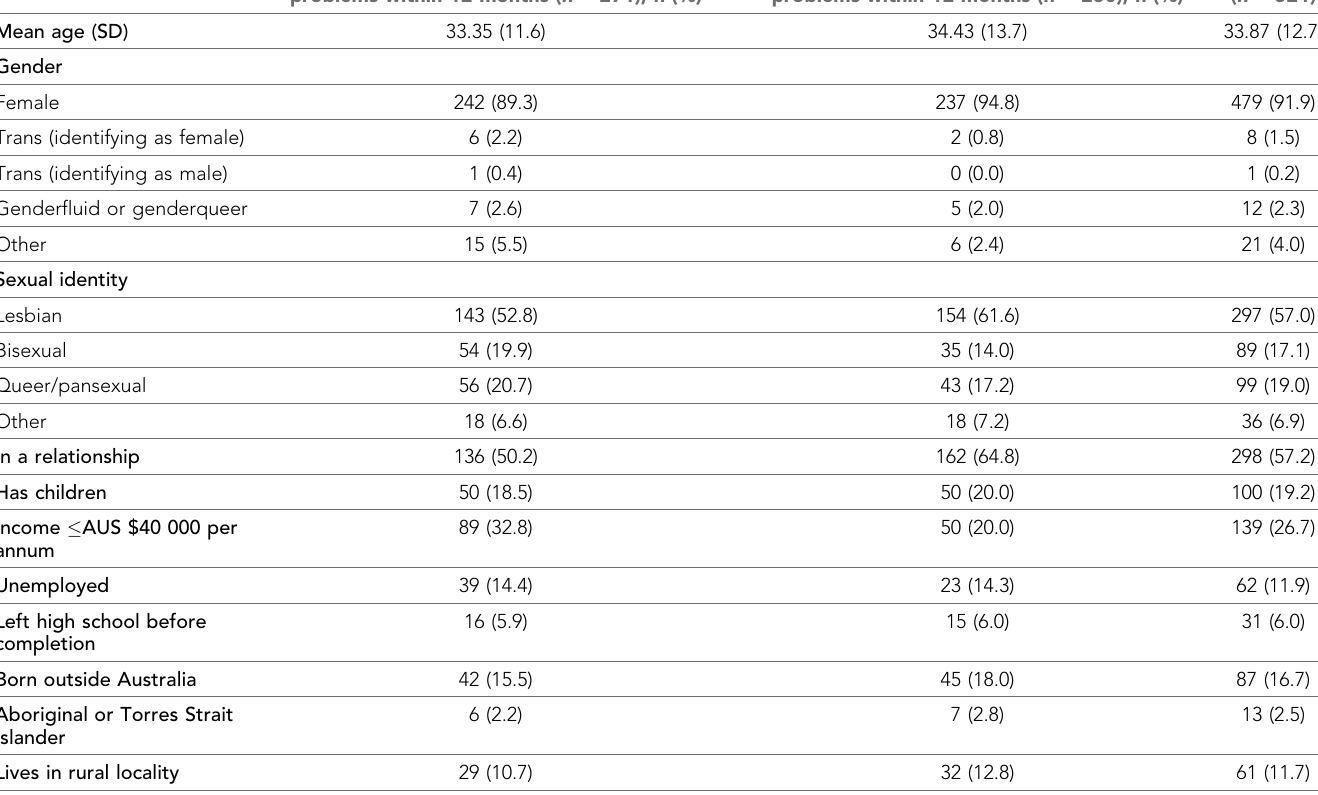
Table 2. Sample demographics by 12-month treatment utilisation for mental health and alcohol-related